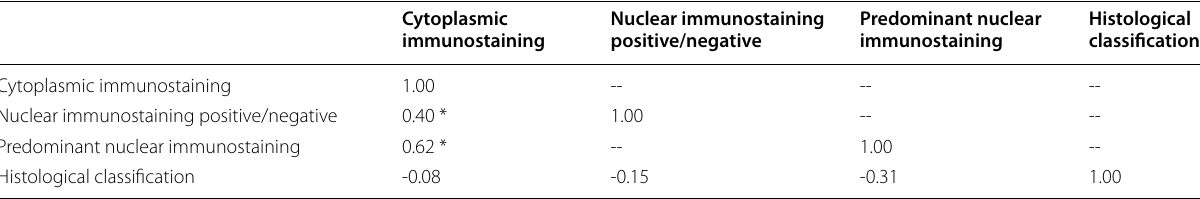
Table 2 Pearson correlation coefficient matrix of Ca Cytoplasmic immunostaining was correlated positively with nuclear immunostaining